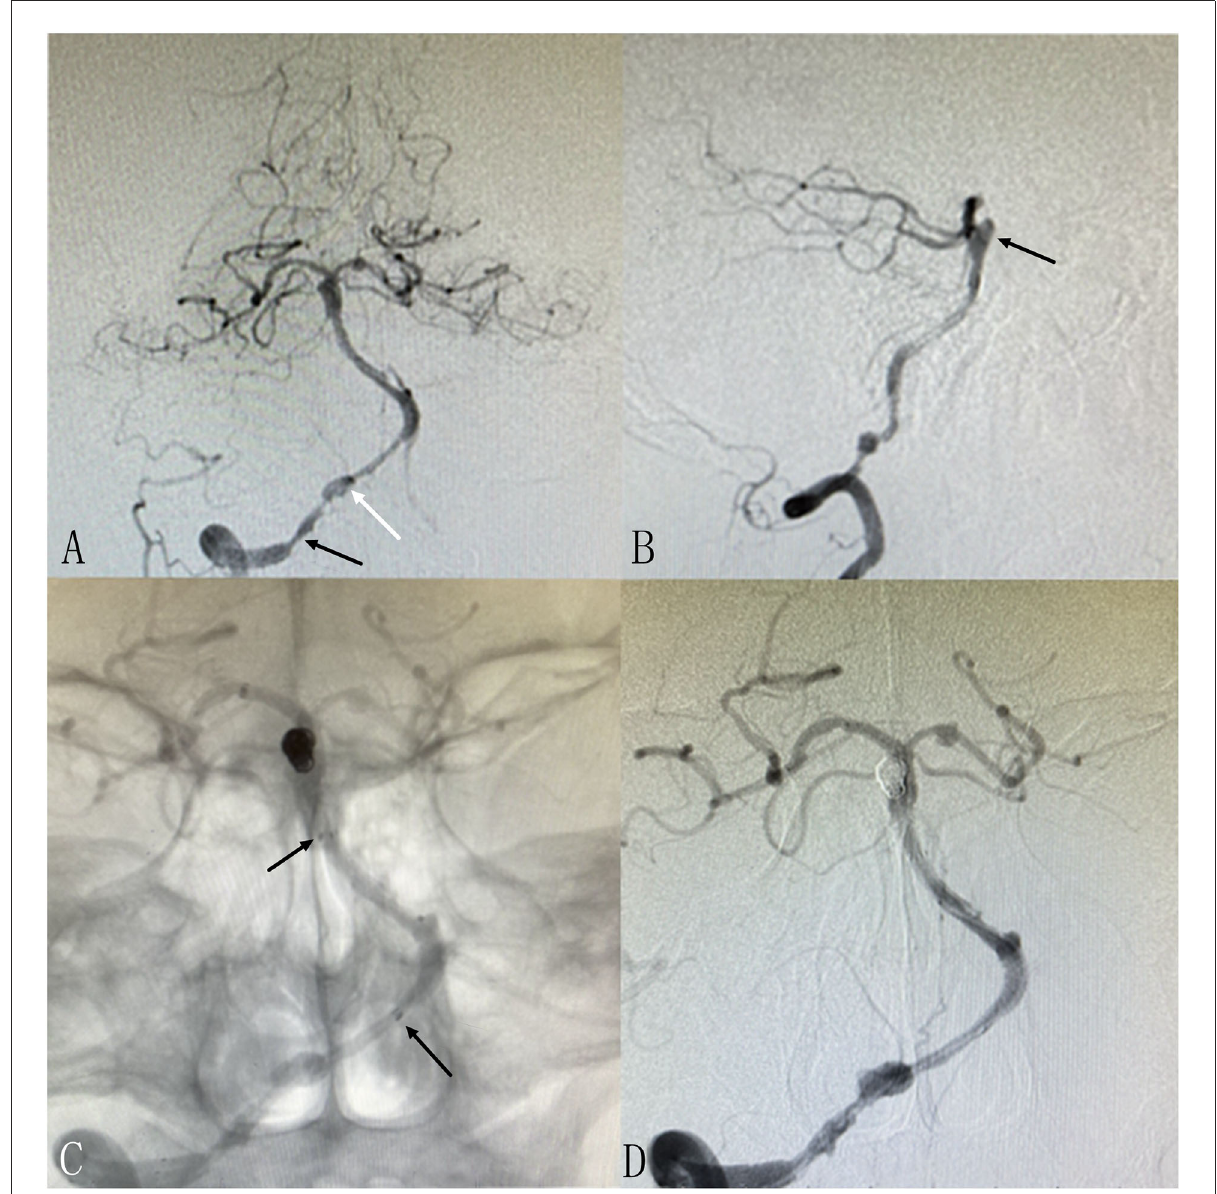
FIGURE1 Patient 3: Single session angioplasty of stenosis and UIA embolization. The patient had mild blurred vision for 10 days. DSA revealed severe stenosis at intracranial segment of the right vertebral artery as well as an basilar aneurysm [ (A,B) , black arrows]. Balloon dilatation and stenting was performed successfully for the stenosis. The aneurysm was embolized with coils and stent in in the same session (C,D) . The markers of the stents are marked [ (C) , black arrows]. There is another small aneurysm located at V4 of RVA adjacent to the stenosis [ (A) , white arrow], which